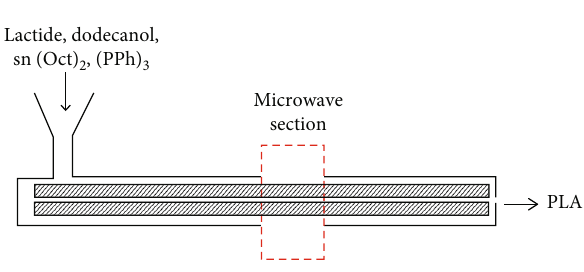
Figure 11: Polymerization reaction of caprolactone under microwaves.